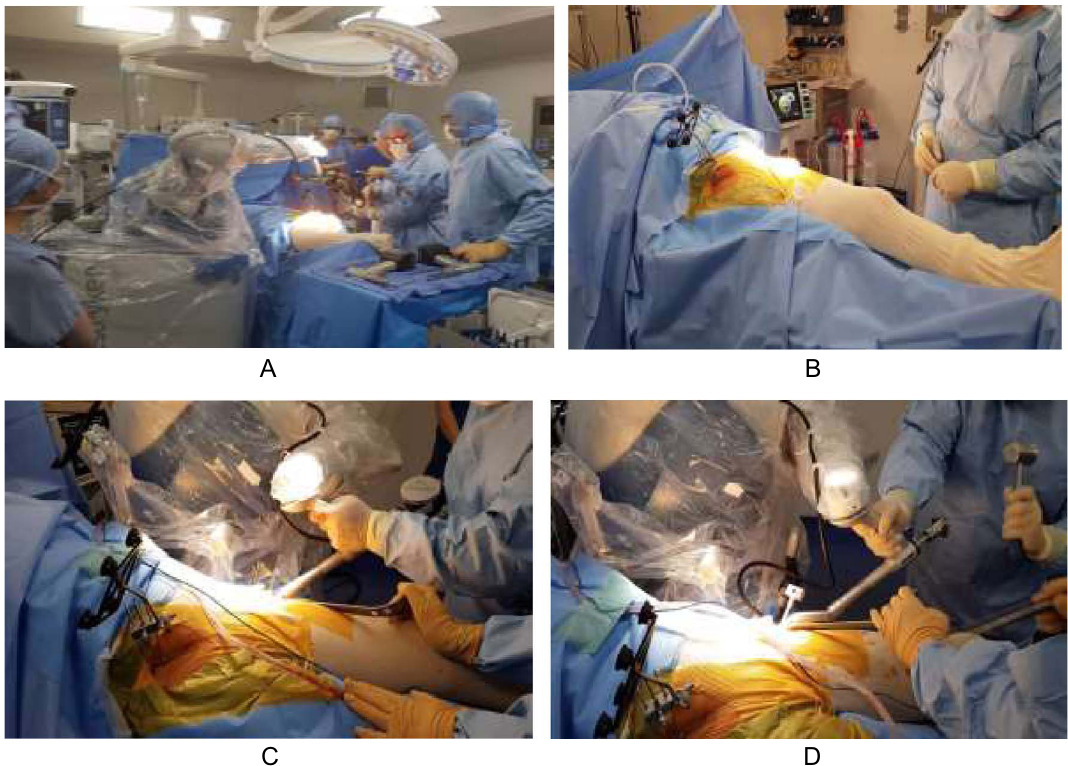
Figure 2. Installation of the robot (Mako TM system) and landmarks during a postero-lateral approach) (A) or a DAA approach (B); during the reaming (DAA) (C) and impaction (D)